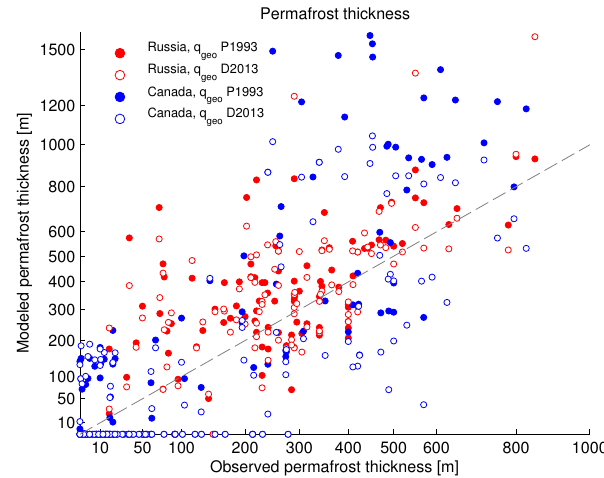
Figure 5. Comparison of modeled present-day permafrost thick- ness with estimates from boreholes. Permafrost thickness data for Canada are from Smith and Burgess (2004) and for Russia from Melnikov (1998). The modeled thickness is for the year AD2000 from the reference model run. Observations are represented by cir- cles with the filling color showing permafrost thickness. The red lines show the extent of continuous, discontinuous and isolated per- mafrost (from dark to light red) after Brown et al. (2014). Black dots indicate grid cells with relict permafrost and grey dots grid cells where the model simulates present-day ice sheet cover.